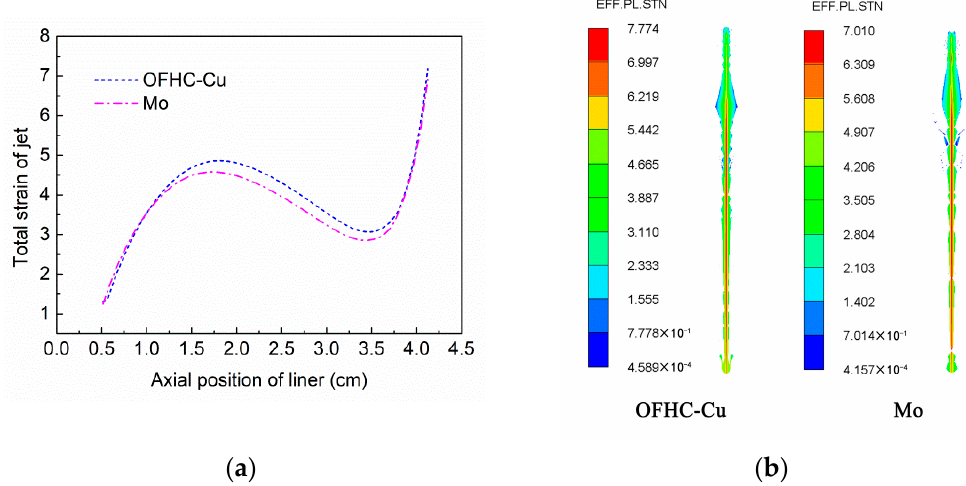
Figure 8. Strain distribution of the OFHC-Cu and Mo jets (at 40 µs). ( a ) Theoretical predictions; ( b ) Numerical simulations.